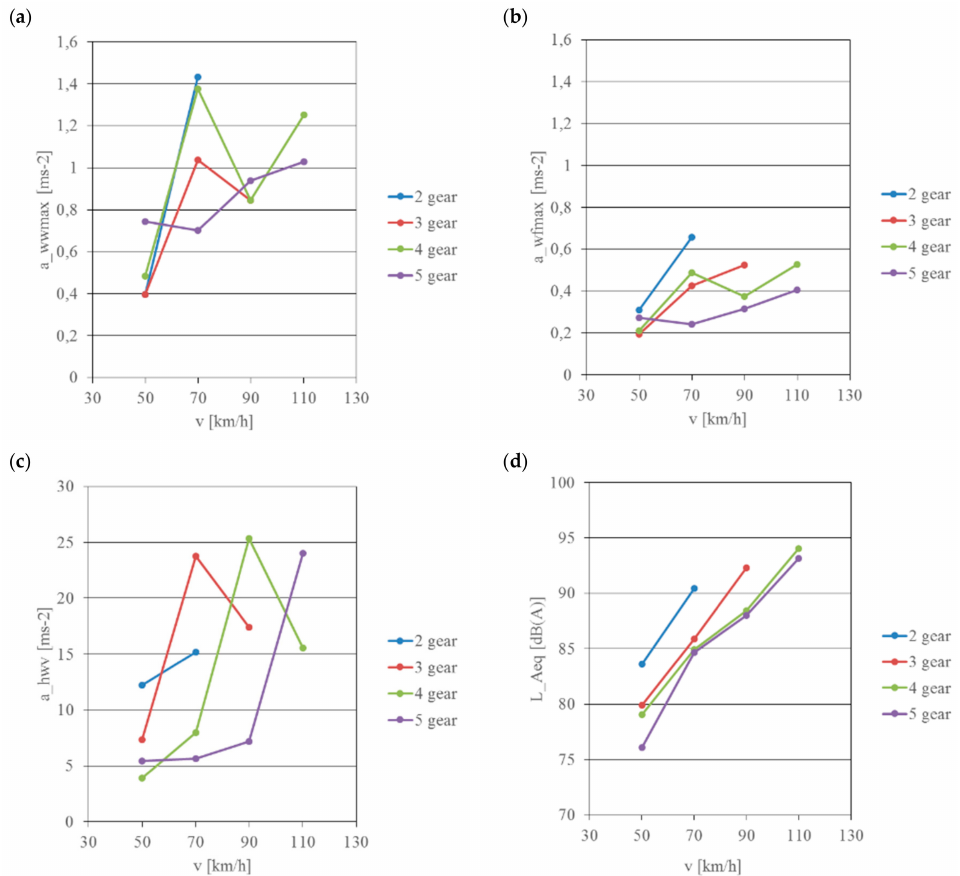
Figure 9. Change of vibration acceleration and noise depending on the travelling speed and the selected gear—frequency corrected signals: ( a ) measuring point—seat, ( b ) measuring point—footrest, ( c ) measuring point—handlebars, ( d ) measuring